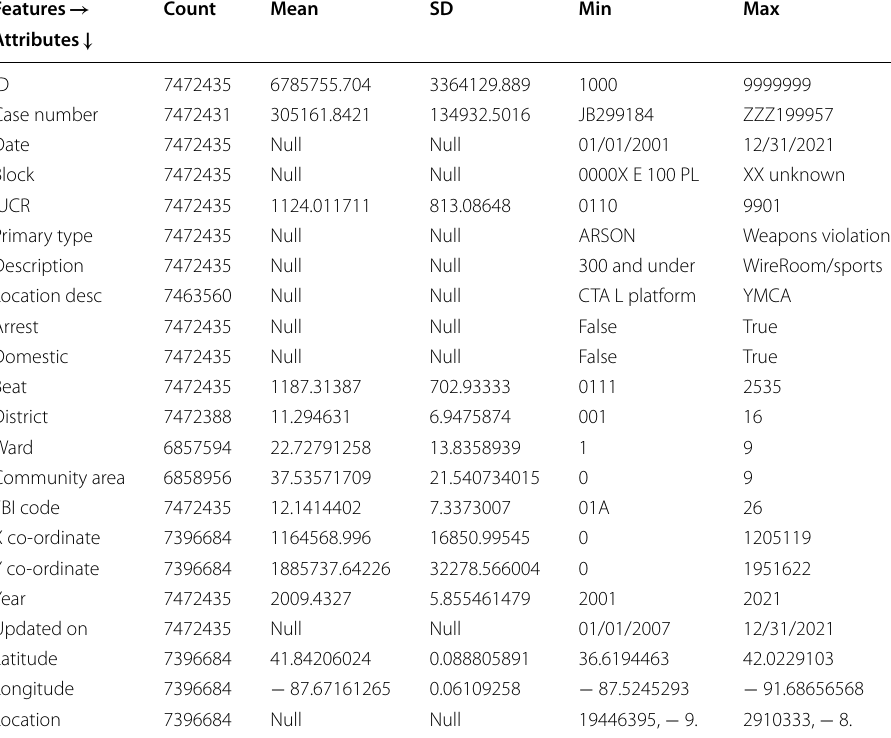
Table 5 Statistical features of the dataset